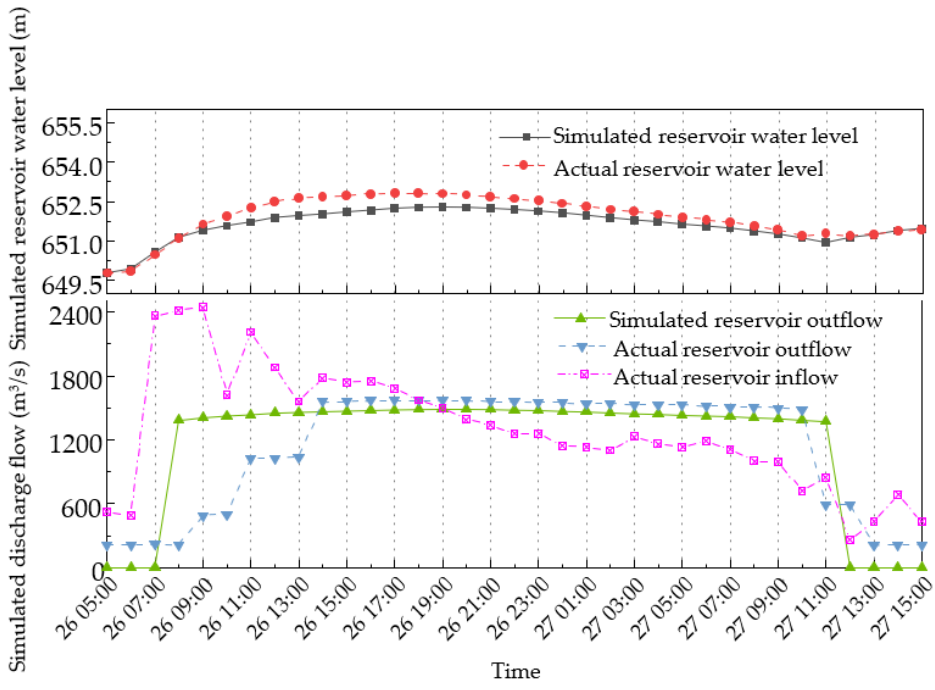
Figure 6. Comparison of water level and outflow discharge between simulated results and actual process under Condition A3.